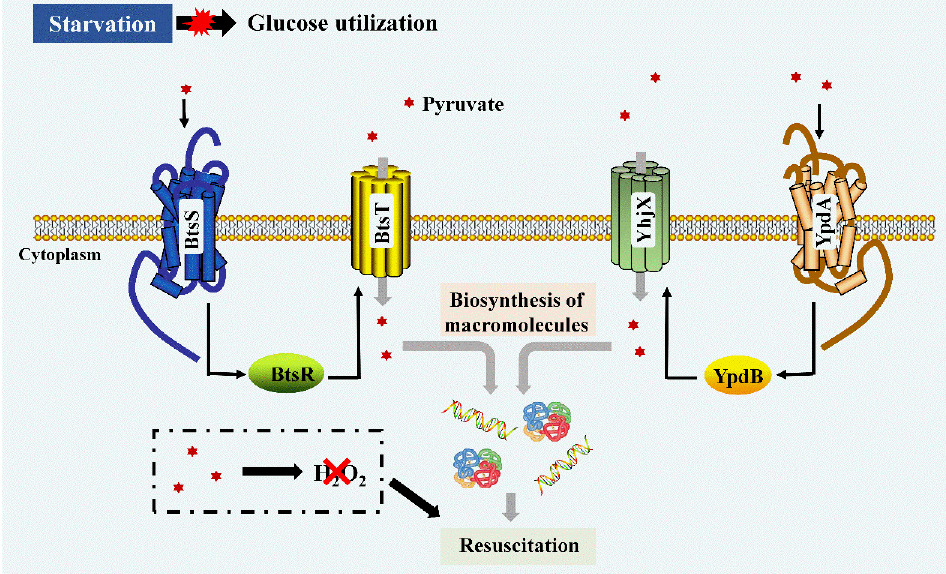
Figure 4. The uptake and utilization of pyruvate to resuscitate VBNC bacteria. Pyruvate was taken up through the high-affinity pyruvate/H+ symporter BstT/YhjX, which was regulated by two pyruvate-sensing hidtidine kinase response regulator systems, BtsS/BtsR and YpdA/YpdB, respectively. BtsSR and YpdAB are two-component systems which respond to extracellular pyruvate, composed of a membrane-integrated histidine kinase (BtsS/YpdA) that can perceive pyruvate, and a cytoplasmic response regulator (BtsR/YpdB) mediates btsT expression. With the import of pyruvate, cells then initiate DNA and protein biosynthesis for growth restoration. The black thin arrows indicate that the proteins/substances promote the synthesize of the transporter of BtsT/YhjX. The grey thick arrows mean the promotion effect of pyruvate to resuscitation through biosynthesis of macromolecules. The black thick arrows mean promotion effect of pyruvate to resuscitation through removing H 2 O 2 .